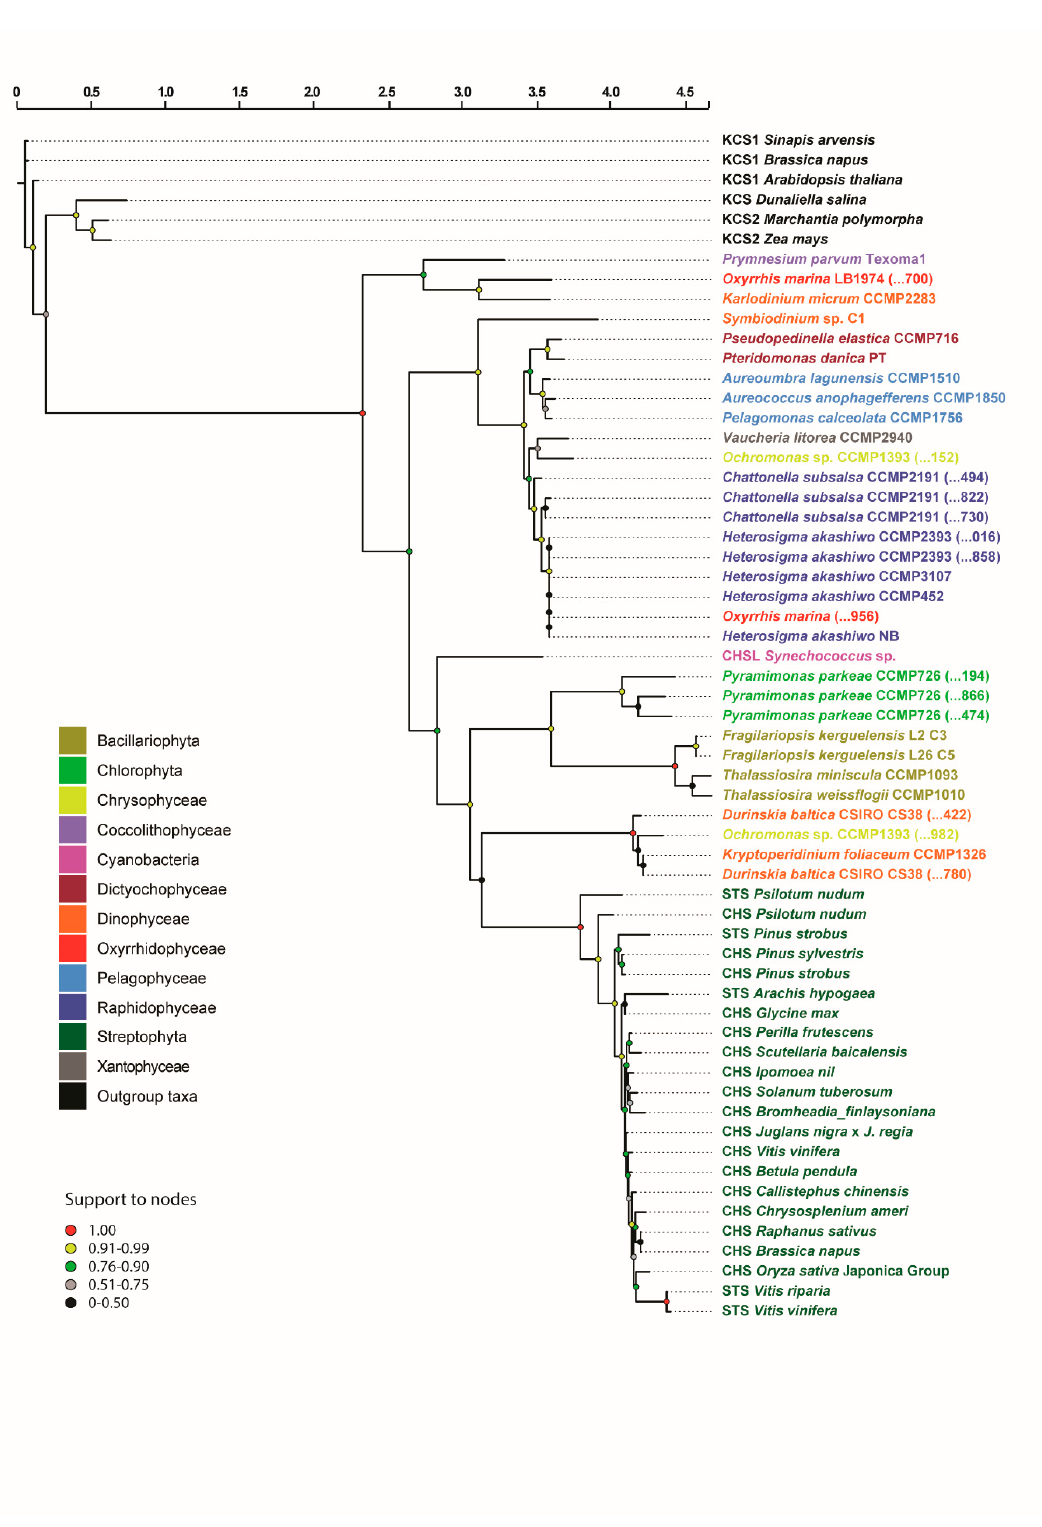
Figure 2. Maximum likelihood phylogenetic tree of chalcone/stilbene synthases. Numbers in parentheses after strain denomination refer to the last three codes of transcripts. Support to nodes was inferred using the Shimodaira-Hasegawa-like test. The final alignment (after trimming procedure) included 60 sequences and 249 characters (File S2). The best evolutionary model for the protein alignment selected using the Akaike Information